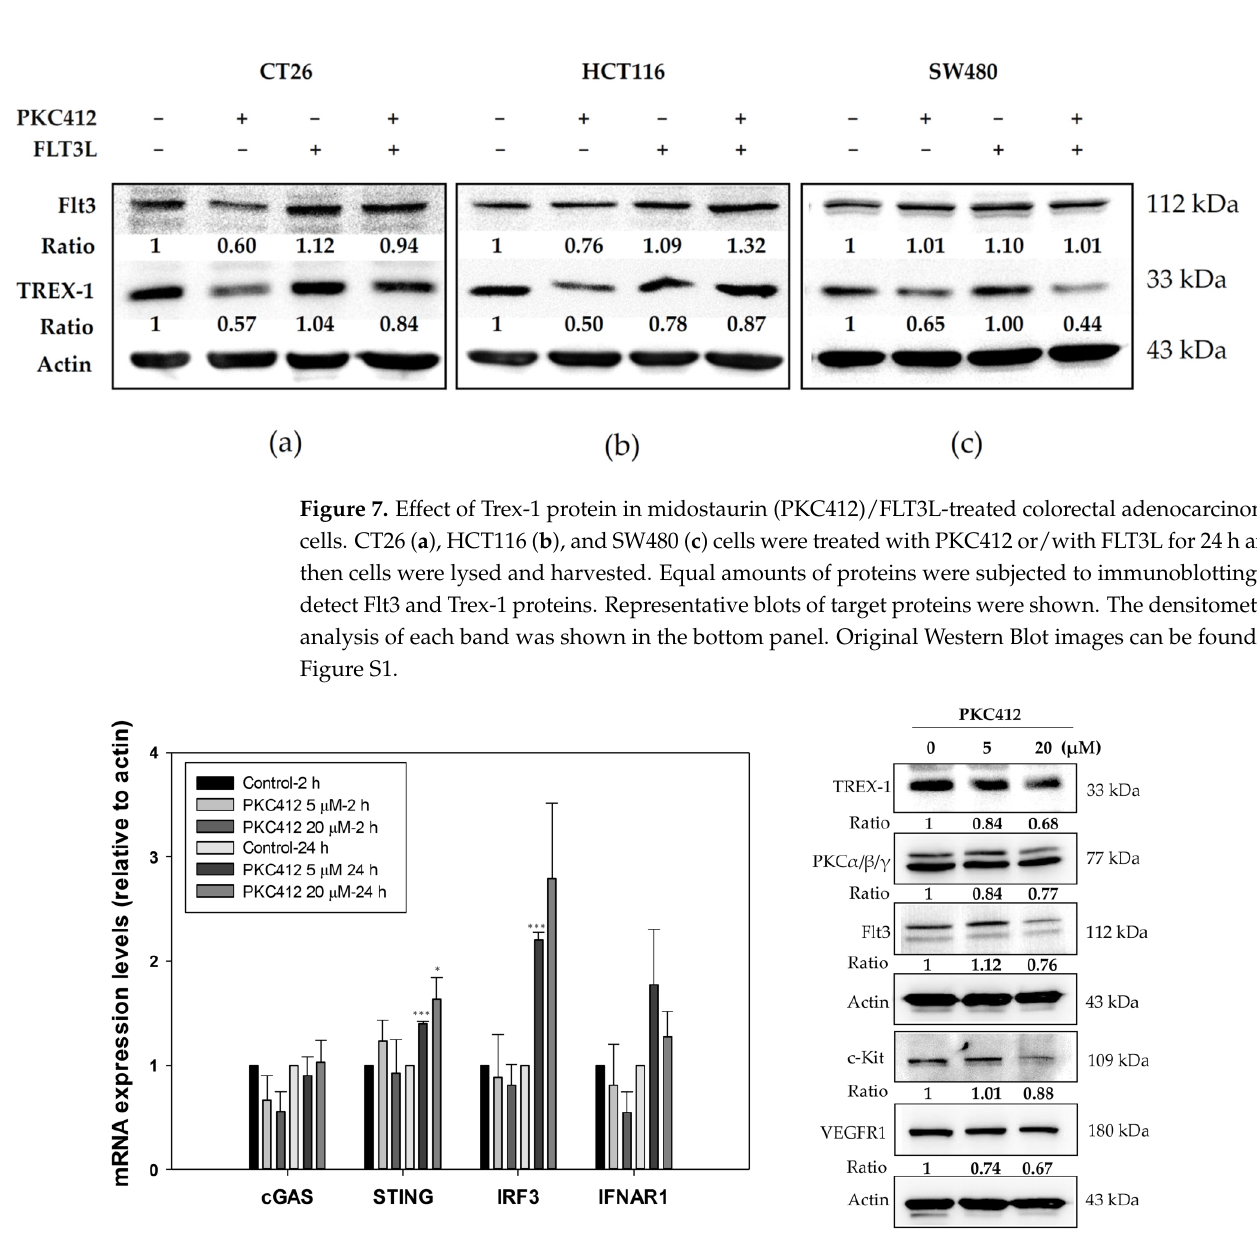
Figure 8. Effect of DNA-sensing signaling and molecular target proteins in midostaurin (PKC412)- treated spleen macrophages. Macrophages were treated with PKC412 for 2 or 24 h and then cells were lysed and harvested. RNA samples were isolated followed by reverse transcription of RNA using primers of DNA-sensing specific genes ( a ). Equal amounts of proteins were subjected to immunoblot- ting to detect midostaurin targets and Trex-1 proteins. Representative blots of midostaurin target proteins were shown ( b ). The densitometric analysis of each band was shown in the bottom panel. Data from three mice spleen macrophages were expressed as mean ± SEM. Significant differences between control cells and cells treated with PKC412 are indicated by * p < 0.05 and *** p < 0.001. Original Western Blot images can be found in Figure